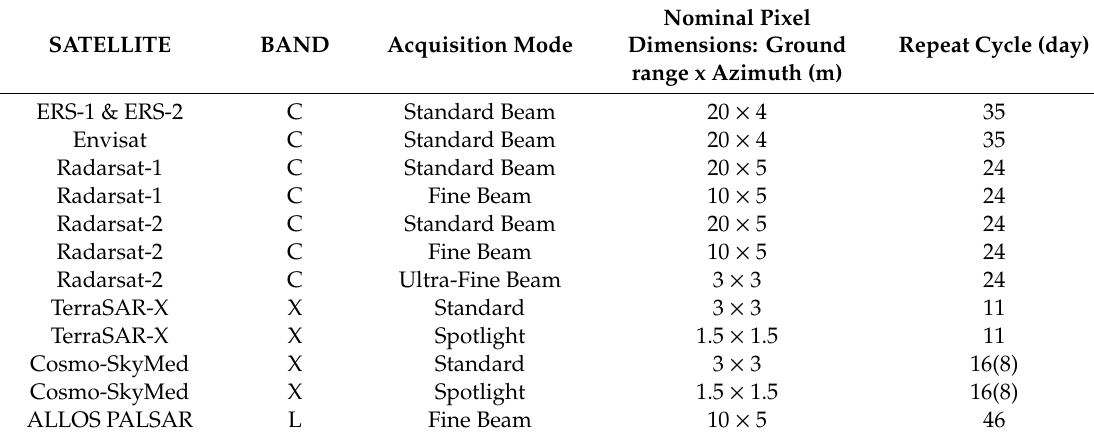
Table 1. Resolution of the most common radar images in meters [31].